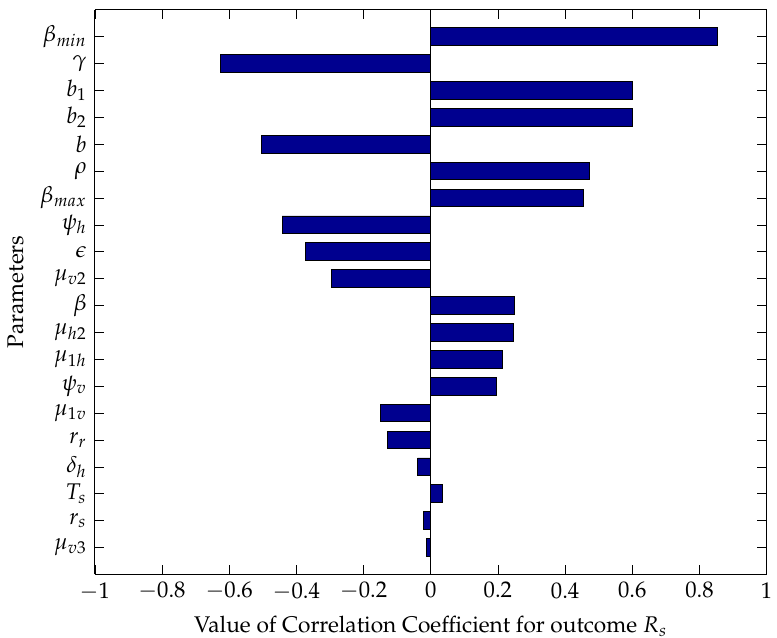
Figure 4. Tornado plot showing the sensitivities of the model parameters affecting the reproduction number for sensitive strain R s